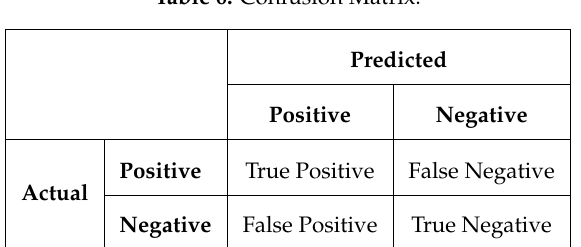
Table 6. Confusion Matrix.